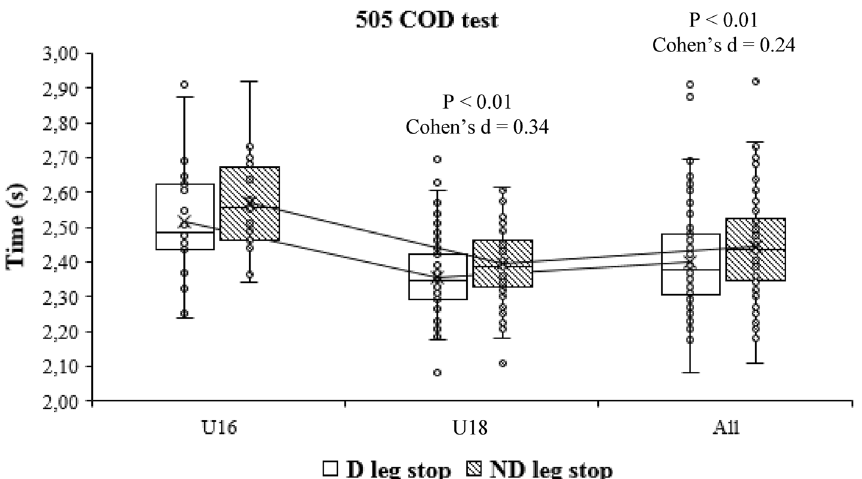
Figure 6. Intragroup comparisons of the 505 COD test. D dominant, ND